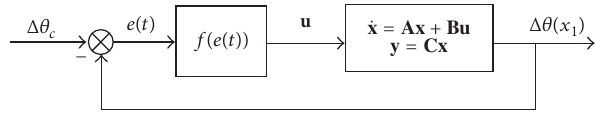
Figure 3: Structure of impulse control